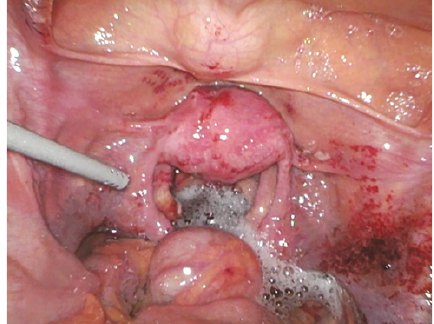
Figure 1: CT scan showing diffuse peritoneal enhancement consis- tent with peritoneal carcinomatosis, 4-quadrant ascites, and slightly enlarged ovaries with solid and cystic structures. The arrow refers to the right ovary.